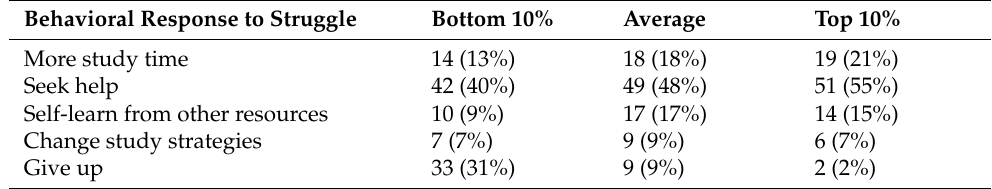
Table 2. Likely Behaviors in Response to